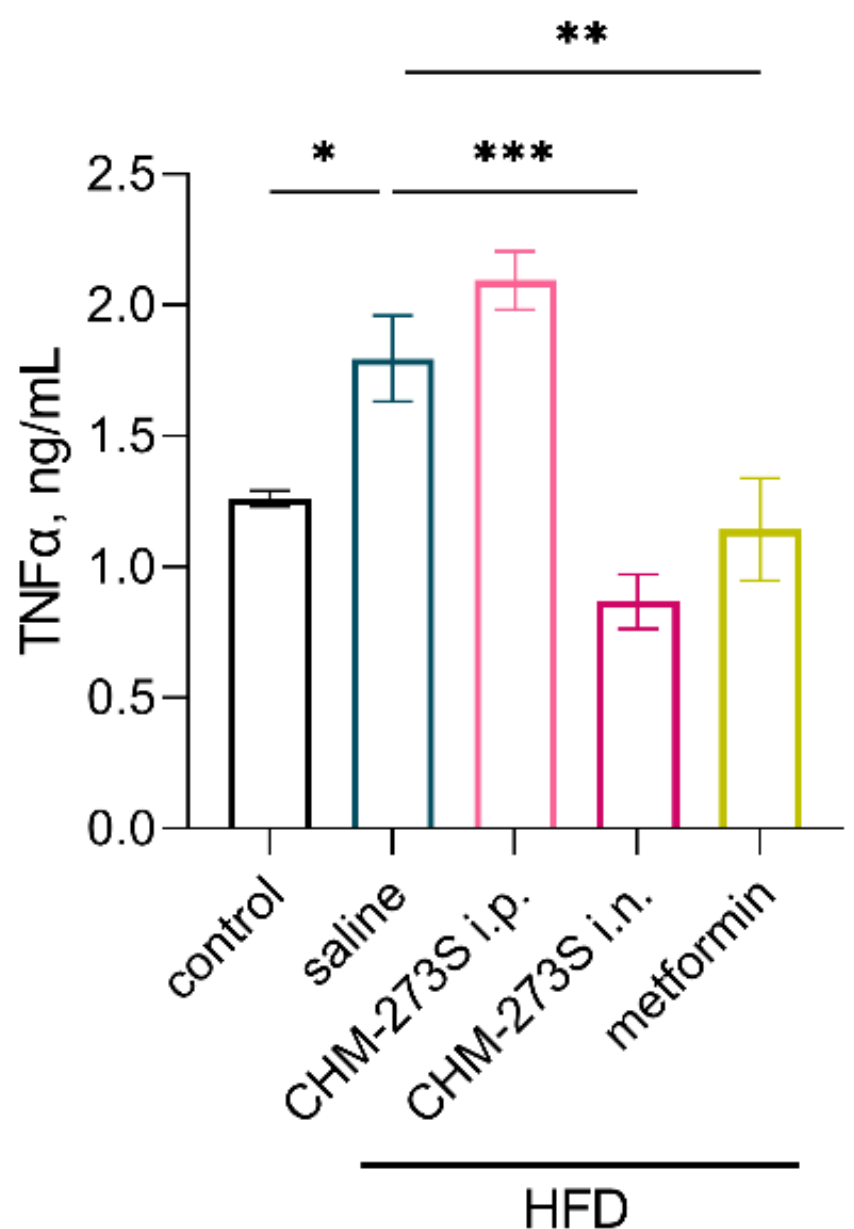
Figure 9. The results of tumor necrosis alpha (TNF α ) immunoassay in mouse serum. The increased circulating TNF α level in the serum of high-fat diet (HFD)-fed mice was abolished by 4-week treatment with CHM-273S (5 mg/kg intranasally, n = 10) or metformin (250 mg/kg perorally, n = 10) (F (4,45) = 12.44, p < 0.0001). The results are presented as the mean ± standard error of the mean. * p < 0.05, ** p < 0.01, *** p < 0.001, versus the HFD-fed, saline-treated group; one-way analysis of variance with the Holm –Šídák multiple comparisons test.